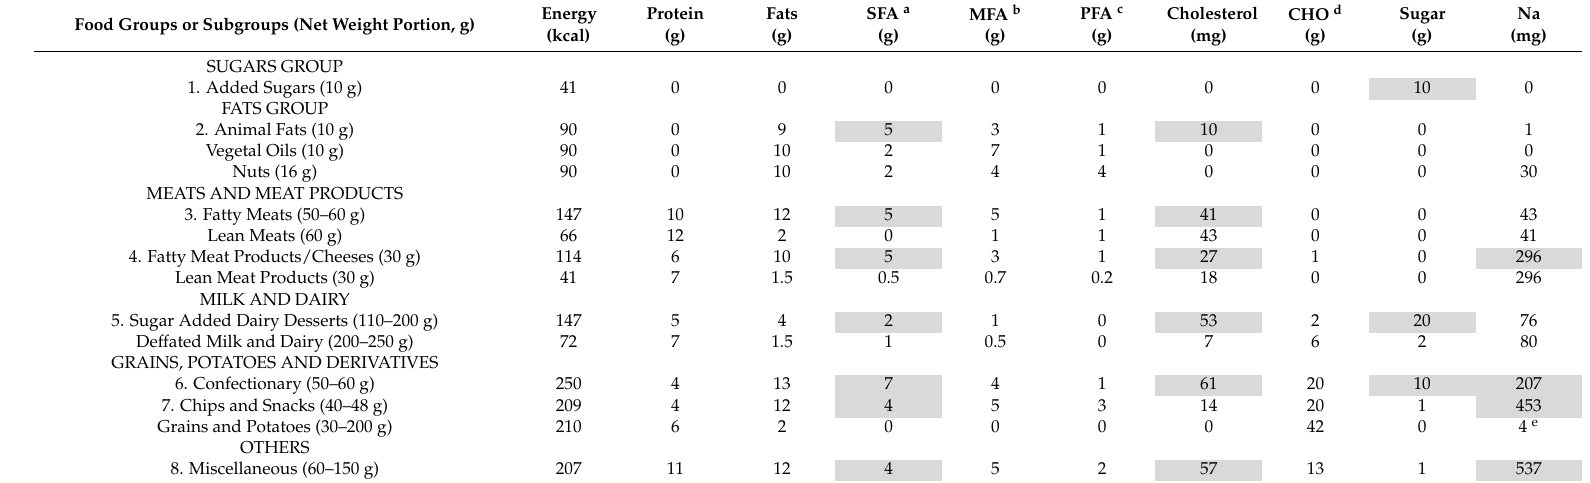
Gray-shaded cells mark a relevant nutritional contribution in groups or subgroups according to European regulation and other